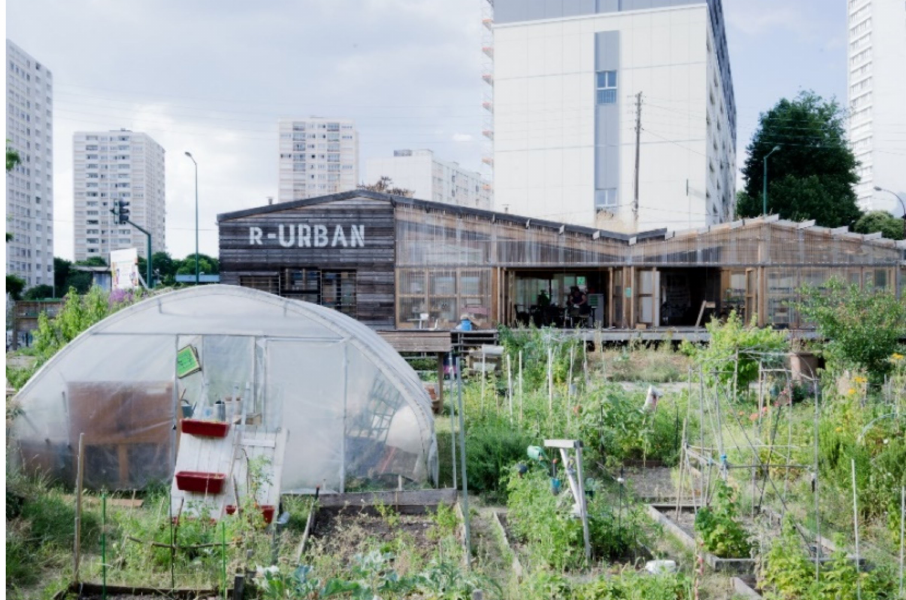
Figure 5. View of AgroCit é in front of the residential area in the Colombes district in Paris,